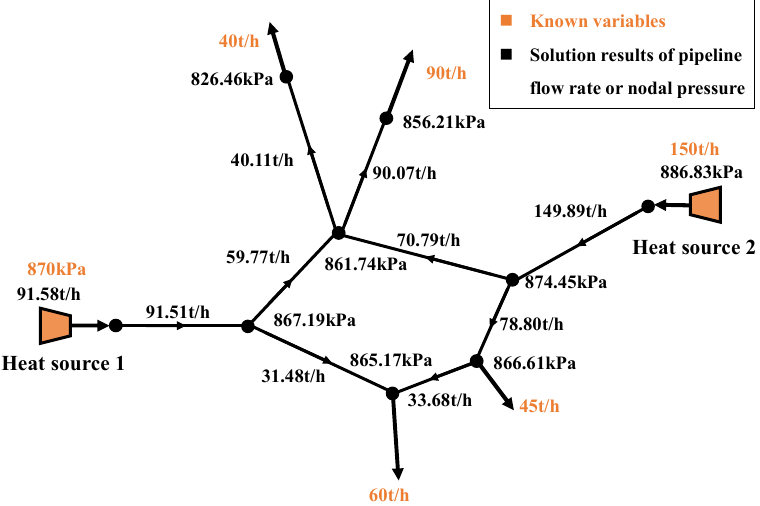
Figure 14. Simulation results of the nine-node double-heat-source ring network.